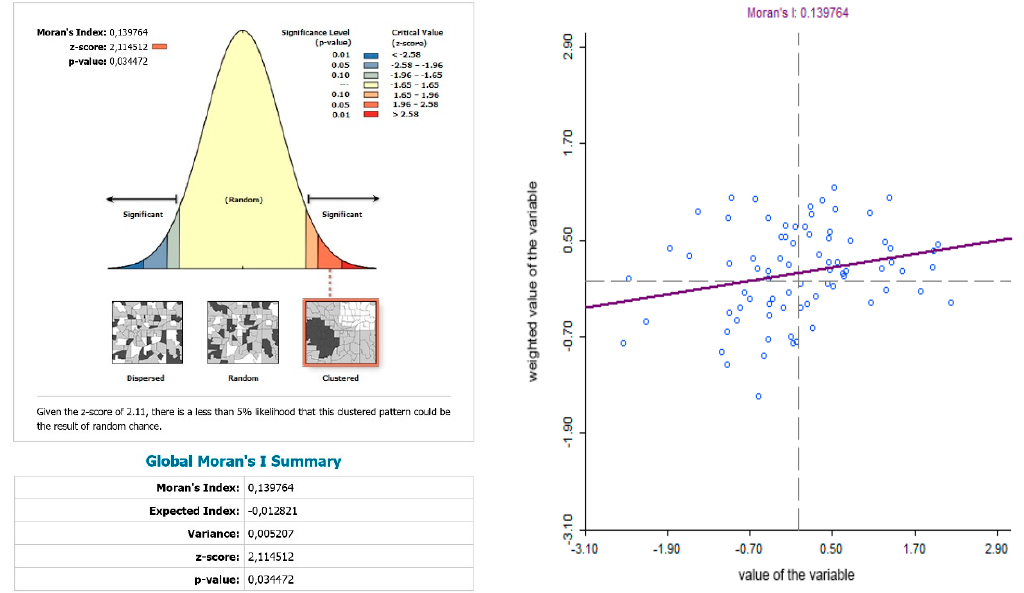
Figure 12 . Final statistics and Moran ′ s diagram for standardized death rate of breast cancer per 1000 inhabitants of European Standard Population, 2001–2006. Source: Statistical Office of the Slovak Republic, 2019.